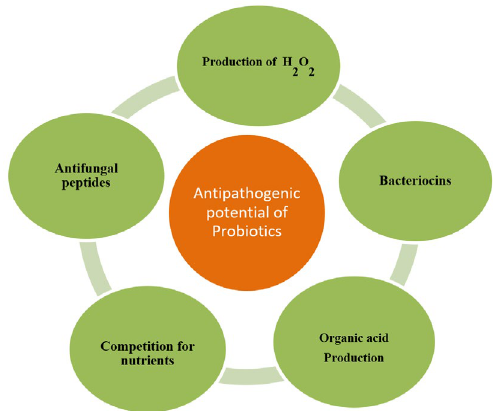
Fig. 1. Antipathogenic Potential of